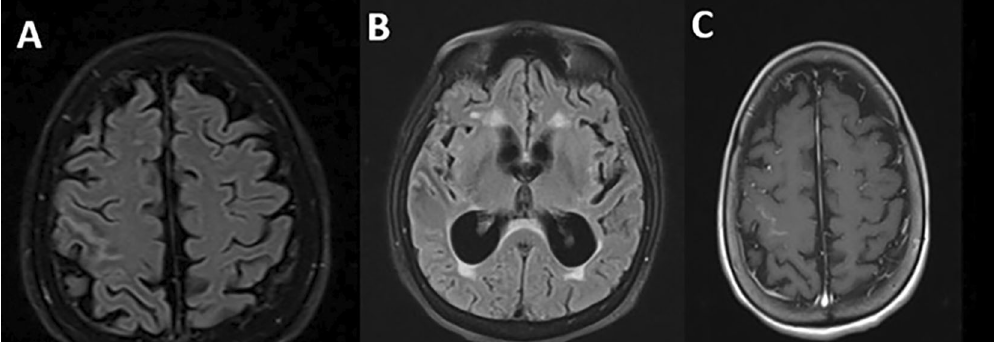
Figure 1. Brain magnetic resonance imaging: A. Irregular leptomeningeal thickening at the right Rolando fissure (thickness 2 mm), as well as smaller adjacent focal parietal leptomeningeal thickening (FLAIR sequence); B. Supratentorial hydrocephalus of recent onset associated with interstitial/transependymal edema (FLAIR sequence); C. No expansive lesions or enhancements in the brain parenchyma (T1 with